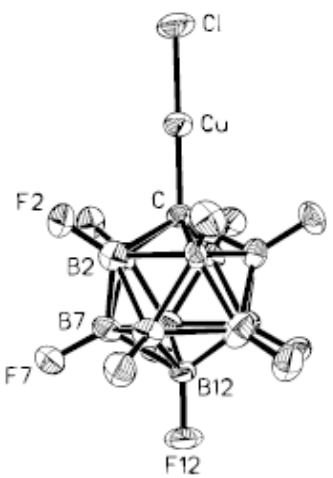
Figure 98. X-ray structure of [1-ClCuCB 11 F 11 ] 2 − anion. Reprinted with permission from reference [112]. Copyright © (1998) American Chemical Society.